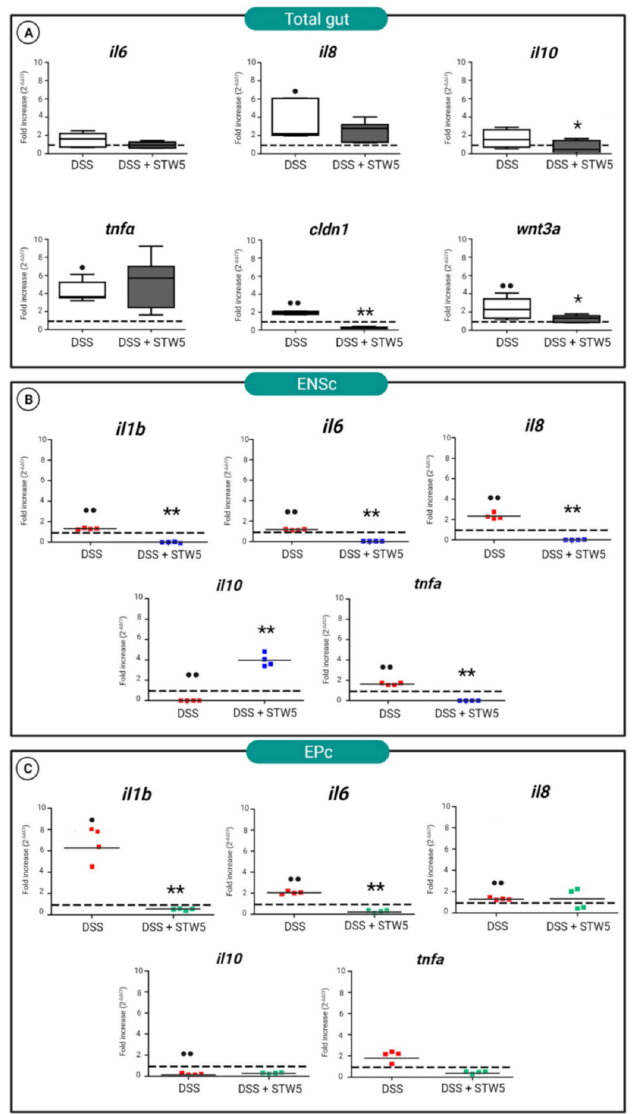
Figure 3. ( A ) Quantitative PCR analysis of il6 , il8 , il10 , tnf α , wnt3a , and cldn1 genes in explanted zebrafish total guts. The tissues were explanted from animals treated for 8 h with DSS (controls) or incubated with STW 5 for 16 h after DSS stimulation. qRT-PCR of il6 , il8 , il10 , and tnf α in ( B ) ENS cultures (ENSc), and ( C ) epithelial cells (EPc). Expression levels were determined as relative to the expression of the housekeeping gene ef1 α , normalized to controls, and calculated using the ∆∆ Ct method based on the equation 2 – ∆∆ Ct ± standard deviation. In the graphs, the expression level of controls was set to 1 and indicated with a dotted line. Statistical significance was calculated using the Wilcoxon test. Samples vs. controls ( • p ≤ 0.05; •• p ≤ 0.01). Samples vs. DSS (* p ≤ 0.05; ** p ≤